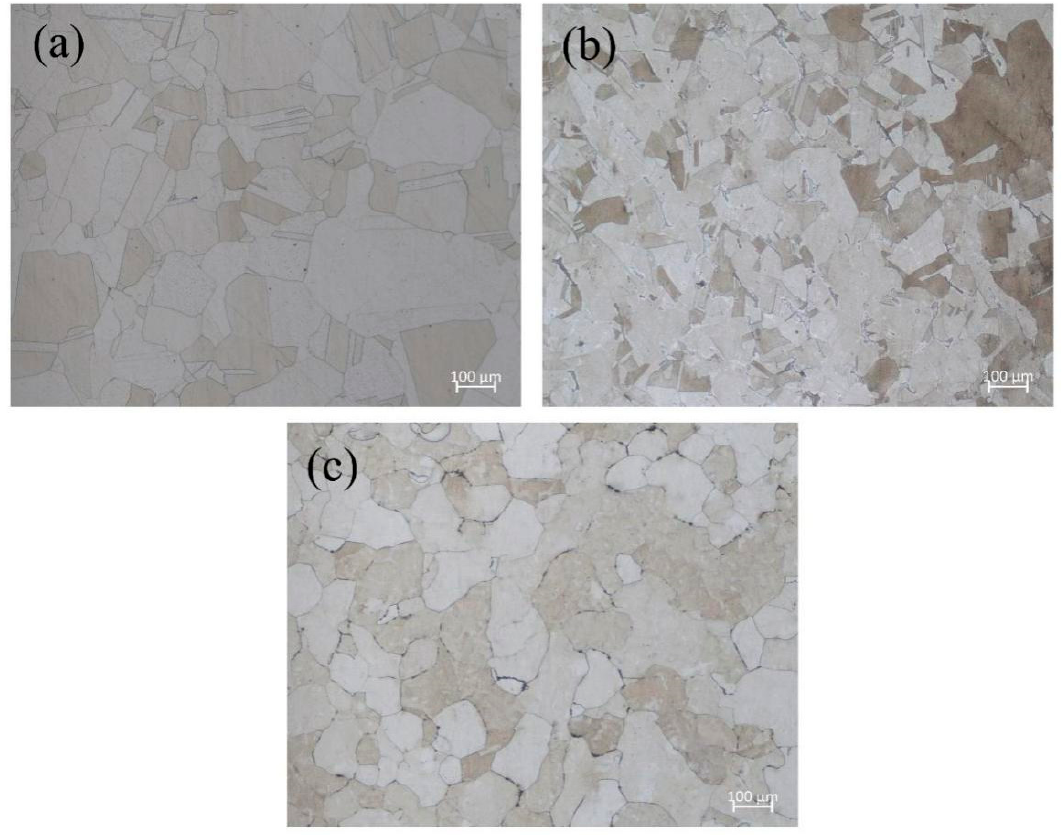
Figure 1. Optical microscope images of the metallographic microstructure of three materials. ( a ) 316L stainless steel; ( b ) 347L stainless steel; ( c ) Co 32 Cr 28 Ni 32.94 Al 4.06 Ti 3 .